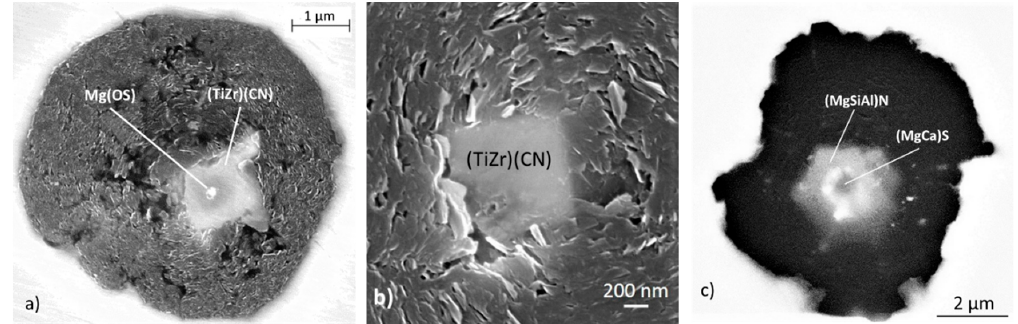
Figure 23. SEM image of Ti-Zr carbonitride and composition map showing Ti and N concentration at the corner and faces of the inclusion (carbonitride) and Mg, Ca, S and O in the middle of the inclusion (oxysulfide) in a sample produced from a 0.03% Ti iron inoculated with a ZrMn inoculant; the presence of Zr was confirmed through the X-ray concentration graph. See Reference [106] for experimental conditions.